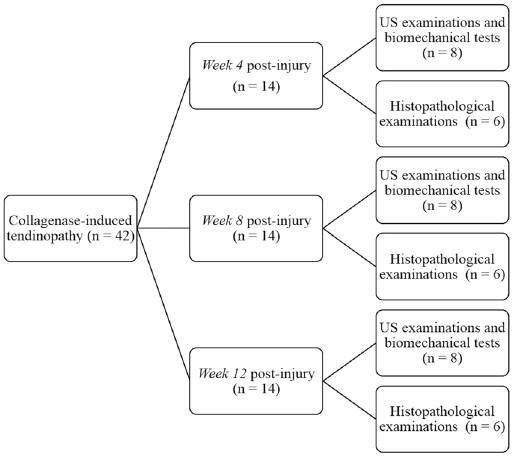
Figure 5. Schematic diagram of the experimental